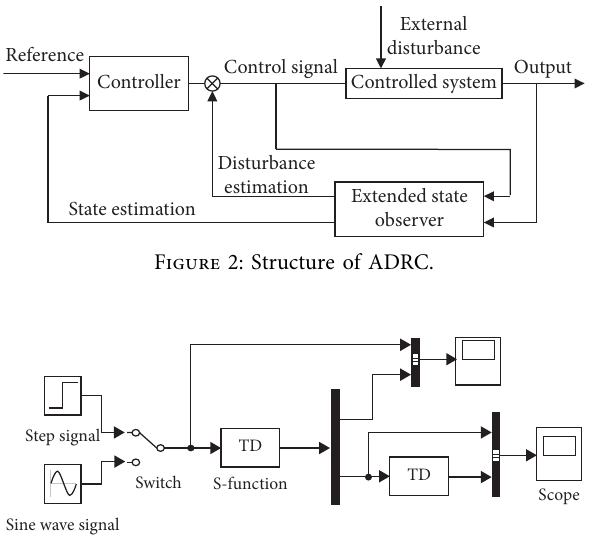
Figure 3: Schematic of the tracking